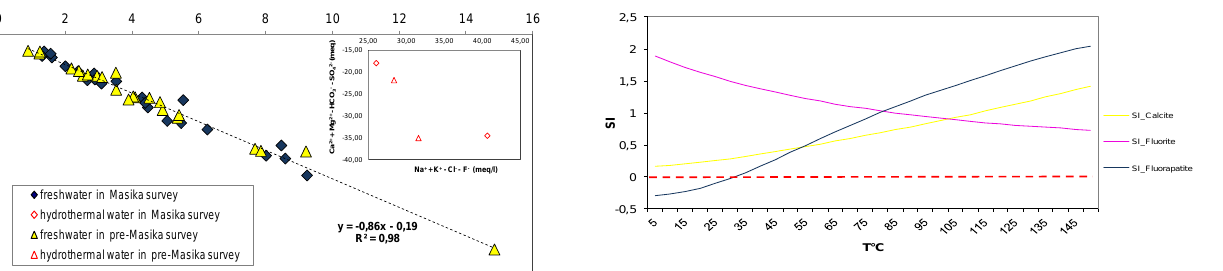
Fig. 15. Plot of the saturation indices of several mineral phases vs. temperature ( ◦ C) for the water of spring 26 ENG.